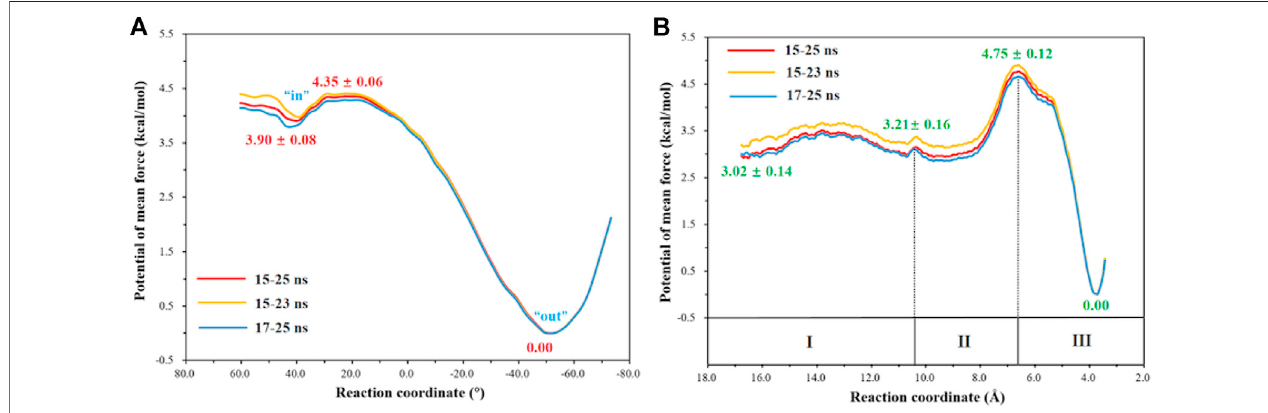
FIGURE9|(A) Freeenergy pro fi lesfortherotationoftheprotonated H64from inward to outward conformation. (B) Freeenergy pro fi lesfortheCO 2 delivery tothe active site of CA.